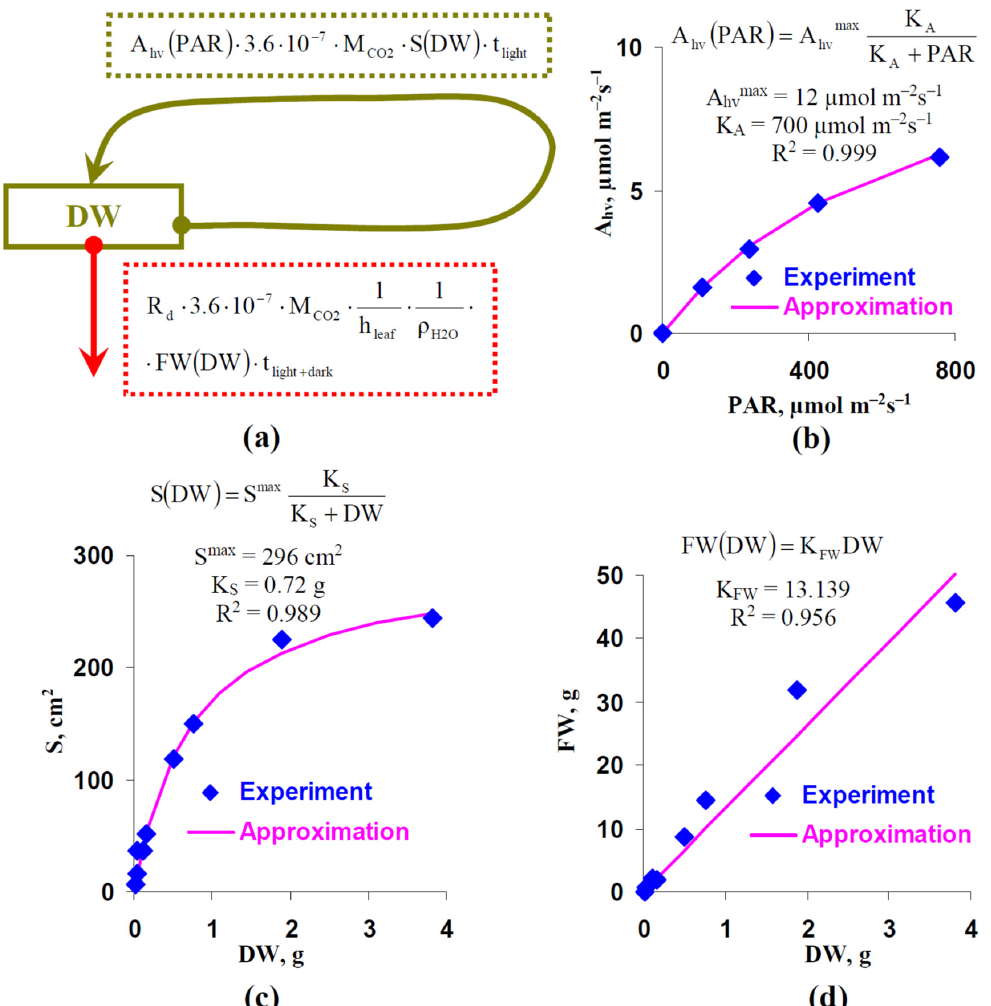
Figure 8. ( a ) Scheme of the simple model of plant production. DW is dry weight of shoot, Ahv(PAR) is the photosynthetic CO 2 assimilation rate under this actinic light intensity (PAR), M CO2 is the molar mass of CO 2 , S(DW) is the green area per plant at this DW which shows the total area of illuminated leaves (or their parts) in the plant, t light is the duration of light period at cultivation, t light+dark is the total duration of light and dark periods at cultivation (24 h), 3.6 · 10 − 7 is correction coefficient for transition of units of A hv (PAR) from µ mol m − 2 s − 1 to mol cm − 2 h − 1 , R d is the average dark respiration rate which was calculated on the basis of all respiration rates in our work (0.769 µ mol m − 2 s − 1 ), h leaf is thickness of lettuce leaf (0.028 cm in accordance with [36]), ρ H2O is the density of water, and FW(DW) is the total biomass of the plant (FW) at this DW. ( b ) The average light dependence of A hv and its approximation. This dependence was calculated on the basis of all light dependences of A hv measured in the current work. The standard equation from chemical kinetic was used for the approximation of A hv (PAR). A hvmax is the maximum rate of the photosynthetic CO 2 assimilation, K A is the light intensity at A hv (PAR) = 0.5 · A hvmax , R 2 is the determination coefficient for the approximation. ( c ) The average dependence of the green area per plant (S) on DW and its approximation. This dependence was calculated on basis of Figure 1 and Table 1 in the current work (all investigated variants). The standard equation from chemical kinetics was used for the approximation of S(DW). S max is the maximum S, K S is the DW at S(DW) = 0.5 · S max , R 2 is the determination coefficient for the approximation. ( d ) Average dependence of FW on DW and its approximation. This dependence was calculated on the basis of Table 1 in the current work (all investigated variant). The standard linear equation was used for the approximation of S(DW). K FW is the coefficient of the linear regression, R 2 is the determination coefficient for the